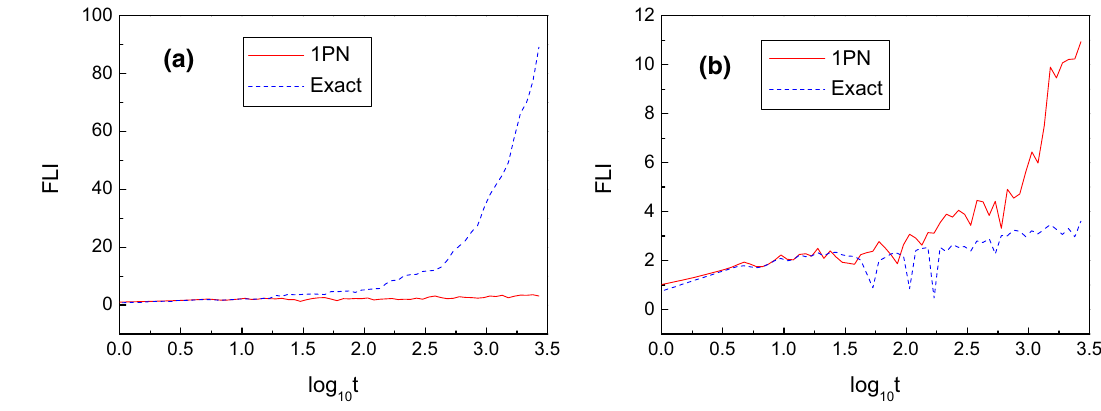
Fig. 15 FLIs of orbits in the two systems with different parameters: a Orbit 1 with a = 63 . 11; b Orbit 3 with a = 77 .